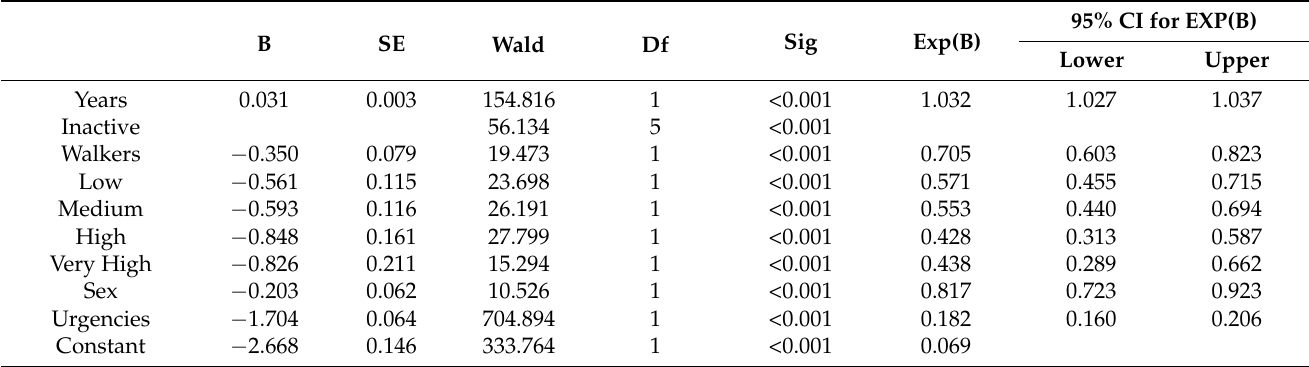
Table 9. Logarithmic binary regression model for the hospitalisation risk